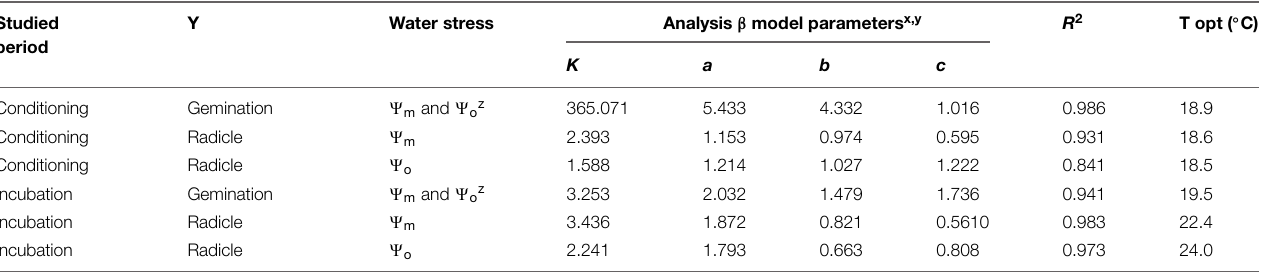
TABLE 1 | Effect of temperature (T), water potential ( (cid:2) t ), and type of water stress [matric ( (cid:2) m ) or osmotic ( (cid:2) o )] during conditioning ( Experiment 1 ) and incubation ( Experiment 3 ) periods on seed germination and radicle length (0–1) of Orobanche crenata seeds according to the fitted Analysis β models. Studied period